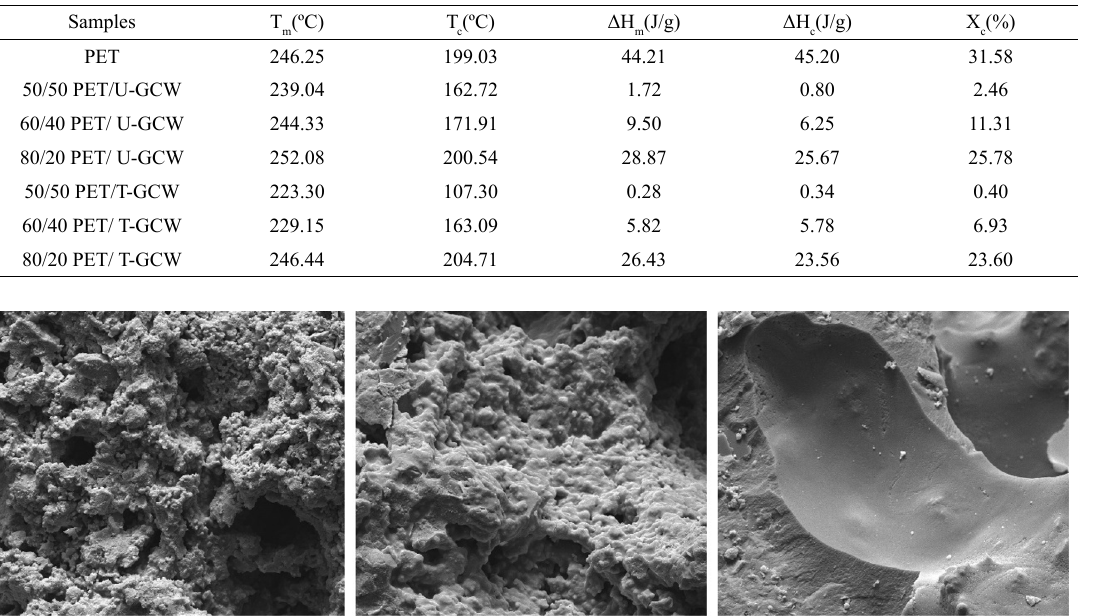
Figure 10. Overlay of the DTG curves of PET/T-GCW composites. Table 6. Calorimetric properties of the specimens.